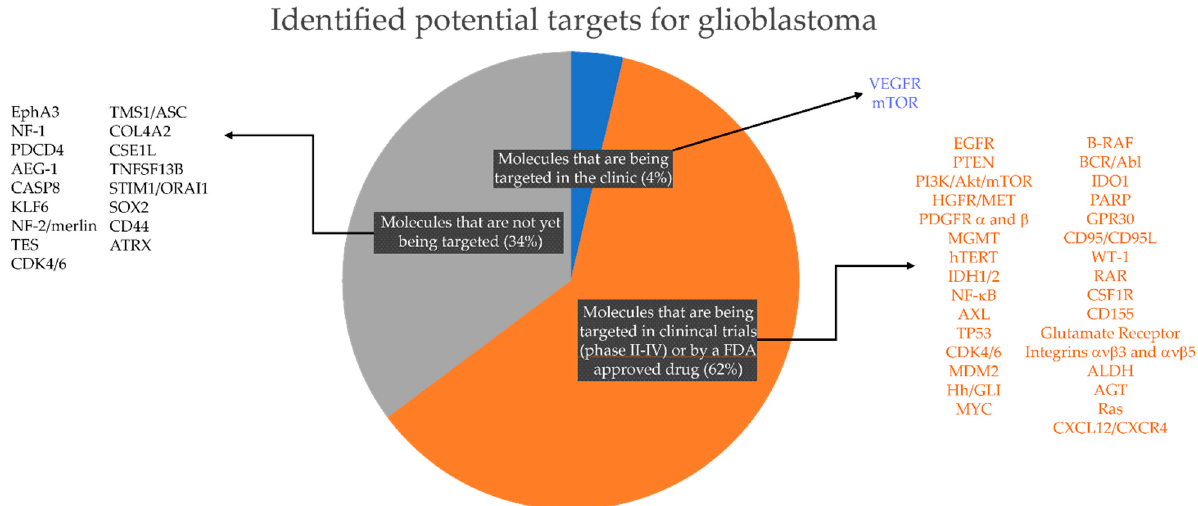
Figure 2. Potential targets for glioblastoma based on literature review, current clinical management and clinical trials for glioblastoma. Note that there are only 2 (4% of the total number of targets identified in this study) targeted therapies currently approved for glioblastoma treatment in the clinic; 31 targeted therapies (62% of total) for which there is a U.S. Food & Drug Administration (FDA)- approved drug and/or are currently being evaluated in glioma/brain tumors clinical trials (https://clinicaltrials.gov); and 17 (34%) recently identified molecular targets for which there is an available drug either FDA-approved but not listed for glioblastoma or an inhibitor developed but not yet clinically approved for any medical condition.